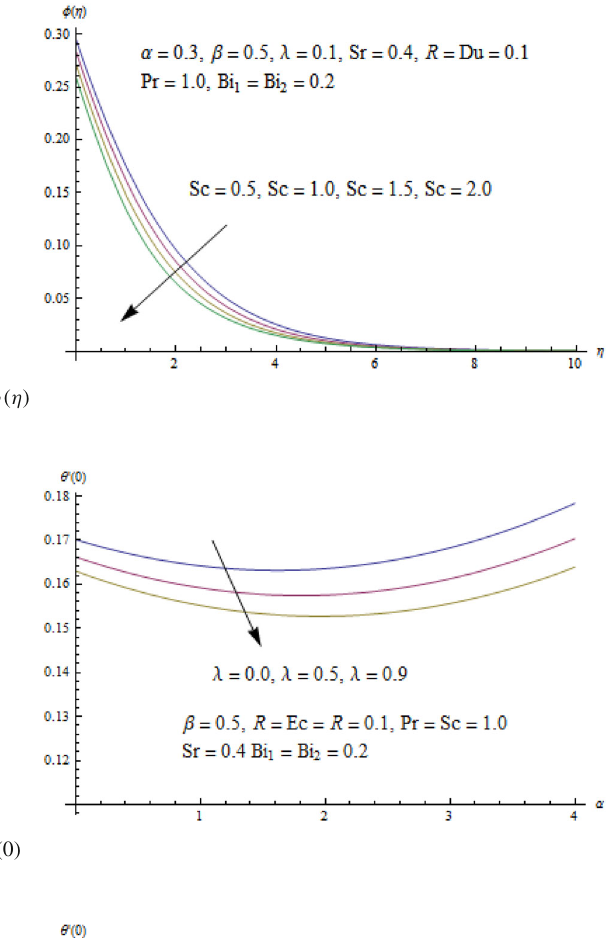
Fig. 26 Impact of λ on θ (cid:5) ( 0 )